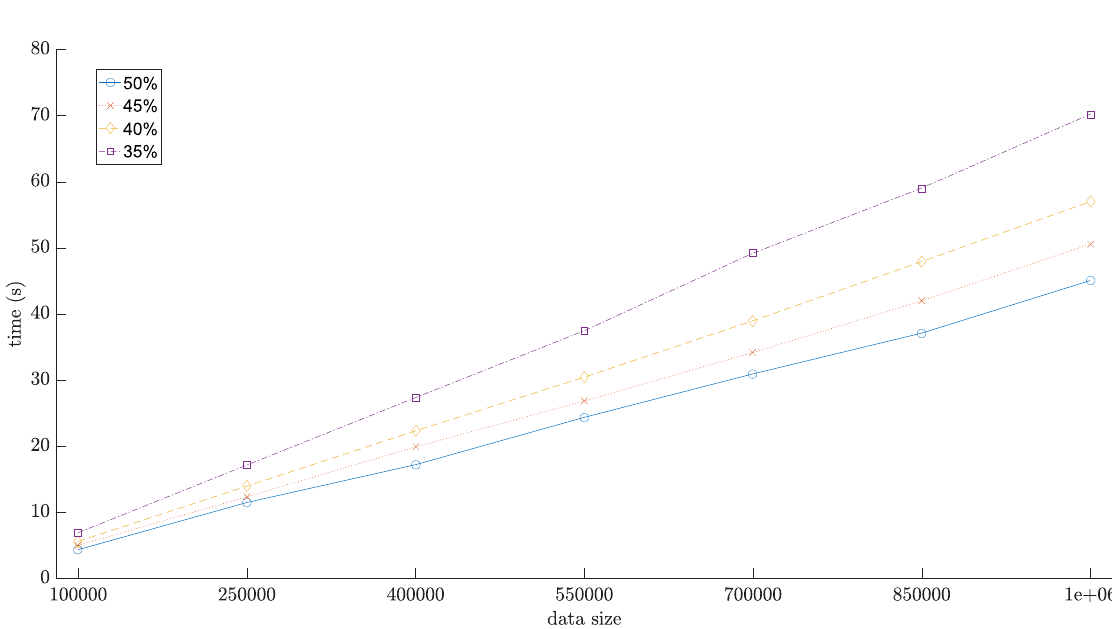
Fig 3. The execution time of fast streaming data sort with respect to the setting of working memory size in terms of percentage of total data size (1,000,000 numbers).